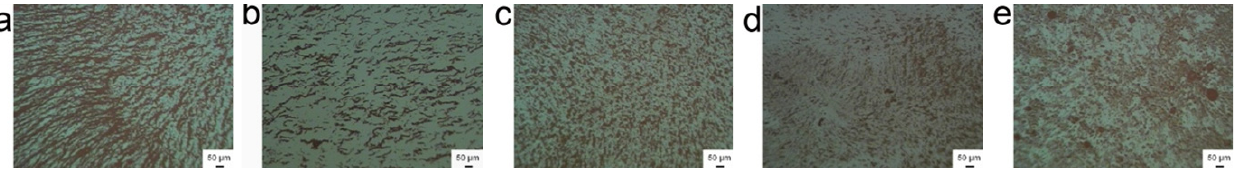
Figure 2. The effect of BSA volume on the field-induced assembly of γ -Fe